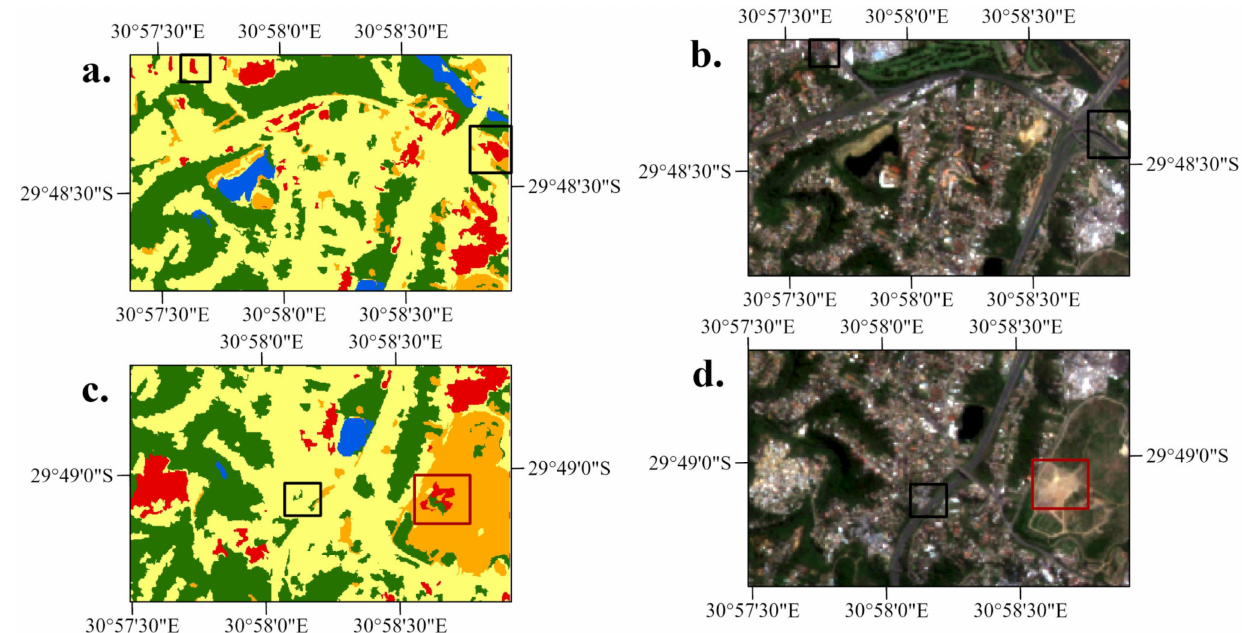
Figure 6. ( a ) shows misclassified informal settlement patches that on the ground ( b ) are commercial buildings. The red rectangles indicate misclassification of bare land ( d ) as informal settlement ( c ) (red patch). The black rectangle indicates missed informal settlement ( c ) that exists on the ground ( d ). The legend for ( a , c ) is included in Figure